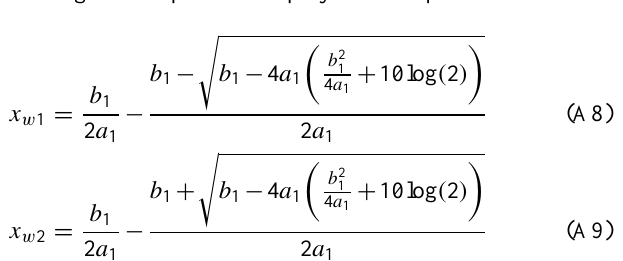
Table 1. Radar positioning errors (in degree).